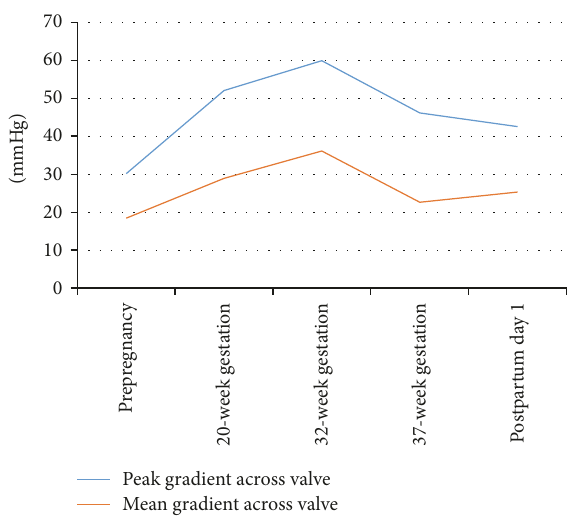
Figure 1: Serial echocardiographic measurements of the mean and peak prosthetic aortic valve gradients over time.